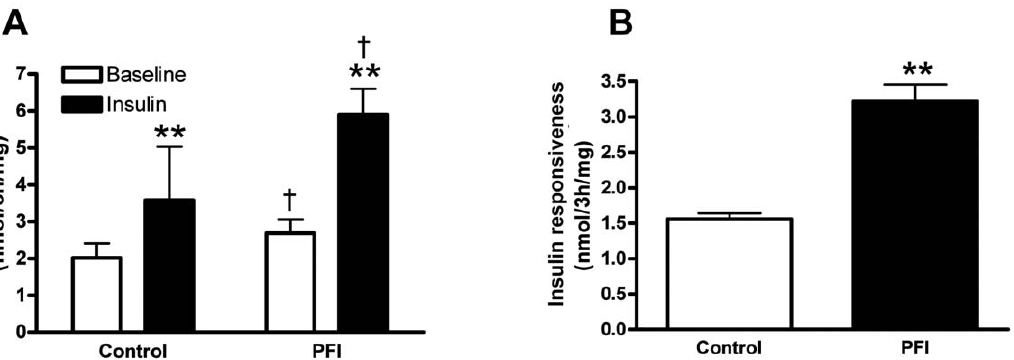
Figure 5. Glucose metabolism and insulin sensitivity. (A) Incorporation of [U- 14 C] glucose into glycogen was measured in either the absence (open bar) or the presence (black bar) of 100 nM of insulin. ** p , 0.01 versus baseline, { p , 0.05 versus control. (B) Insulin-stimulated glycogen storage was measured by the change in glycogen storage at baseline in response to insulin and used as a marker of insulin responsiveness in this model. Data are expressed as mean 6 SEM of 4 separate experiments. ** p , 0.01 versus control.